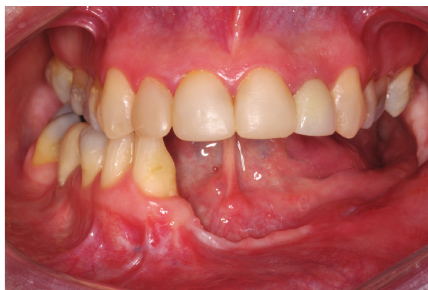
Figure 8: Front view before second surgery stage. Figure 9: Prosthesis installed 1 year after tumor resection.